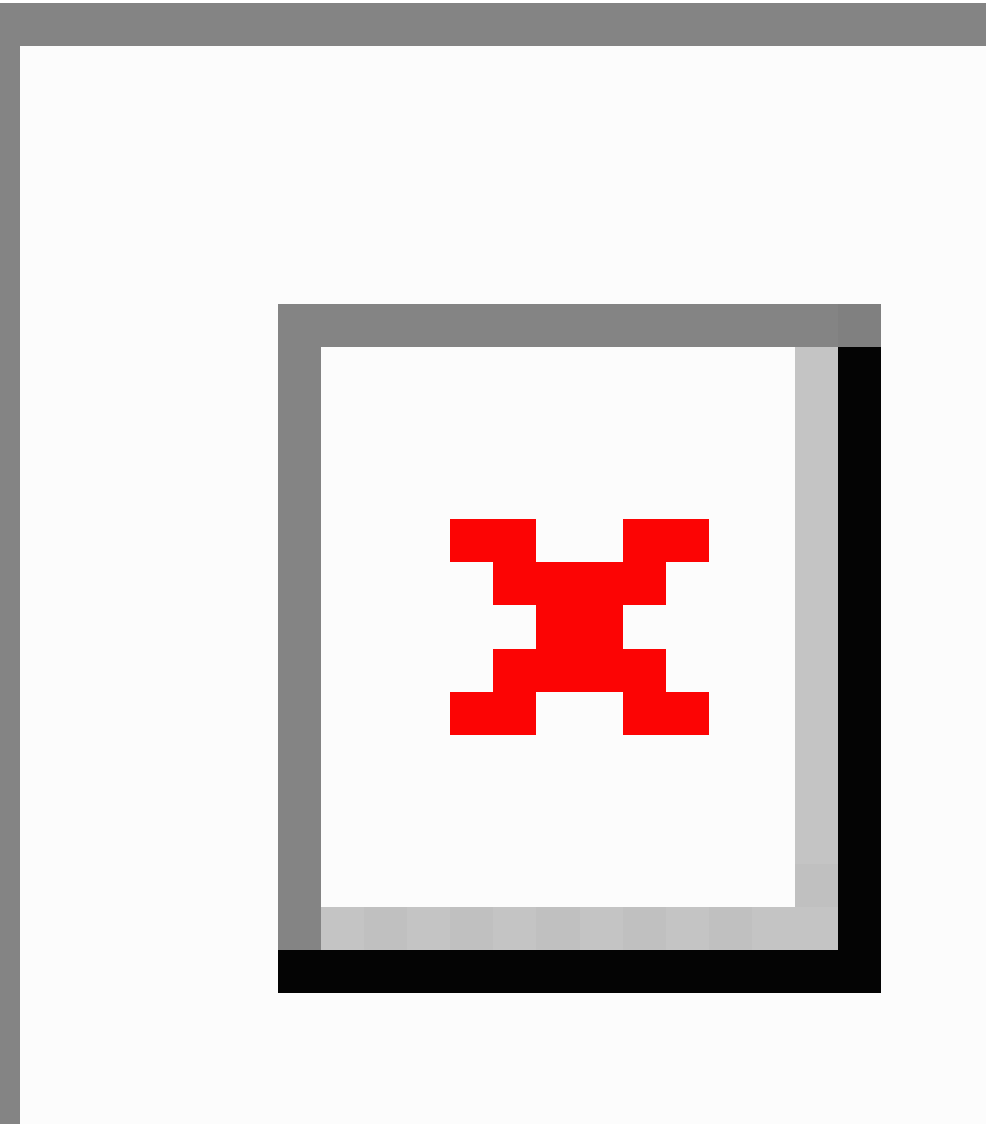
Figure 5. Detailed results showing grading (green, yellow, orange, or red) for each